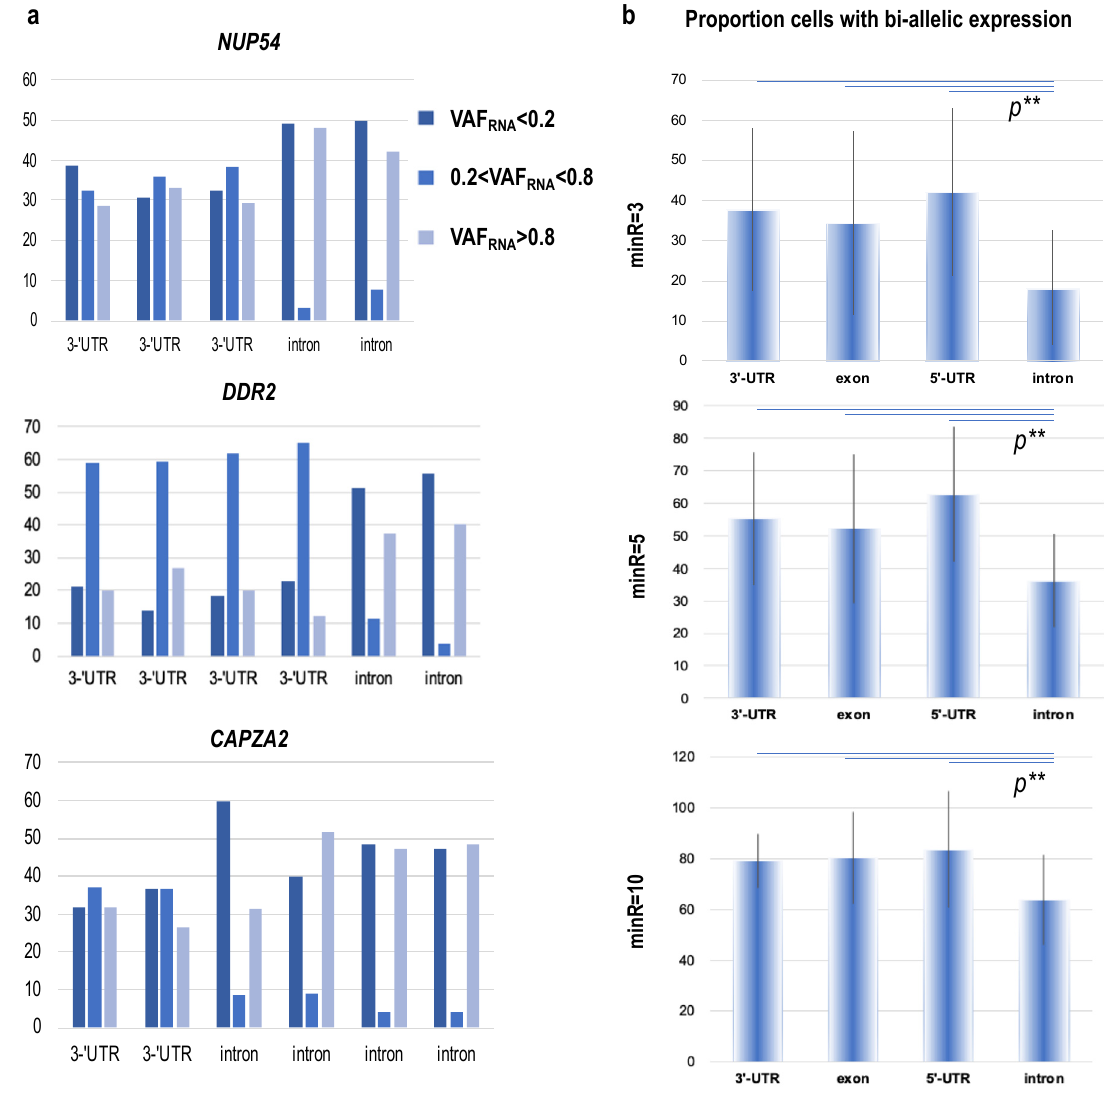
Figure 8. ( a ) Genes with multiple SNVs positioned in intronic and non-intronic sequences; high percentage of random monoallelic expression (RME) cells (VAF RNA < 0.2 or > 0.8, y-axis) is obvious. ( b ) Average percentage of cells (y-axis) with bi-allelic expression across all SNVs in our dataset stratified by position in the gene; SNVs positioned in introns were be-allelic in a lower proportion of cells as compared to all other SNVs.